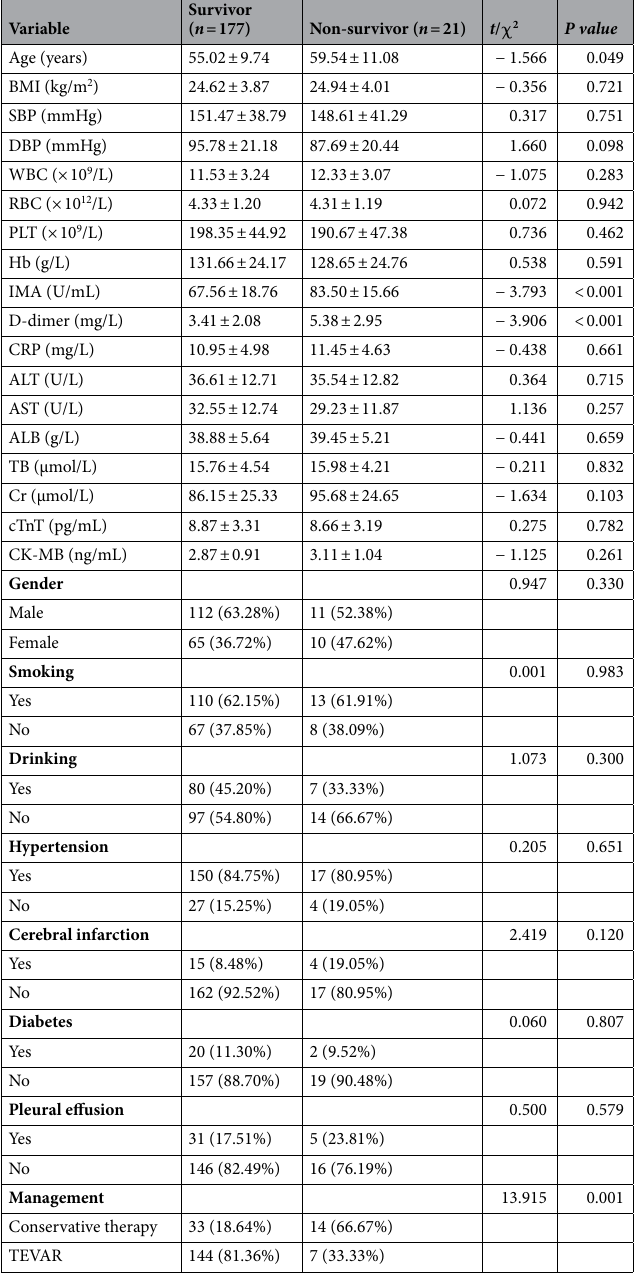
Table 3. Univariate analyses of variables associated with in-hospital mortality in TBAD. BMI, body mass index; SBP, systolic blood pressure; DBP, diastole blood pressure; WBC, white blood cell; RBC, red blood cell; PLT, platelets; Hb, hemoglobin; IMA, ischemic modified albumin; CRP, C-reactive protein; ALT, alanine transaminase; AST, aspartate aminotransferase; ALB, albumin; TB, total bilirubin; Cr, creatinine; cTnT, troponin T; CK-MB, creatine kinase MB; TBAD, Stanford type B aortic dissection; TEVAR, thoracic endovascular aortic